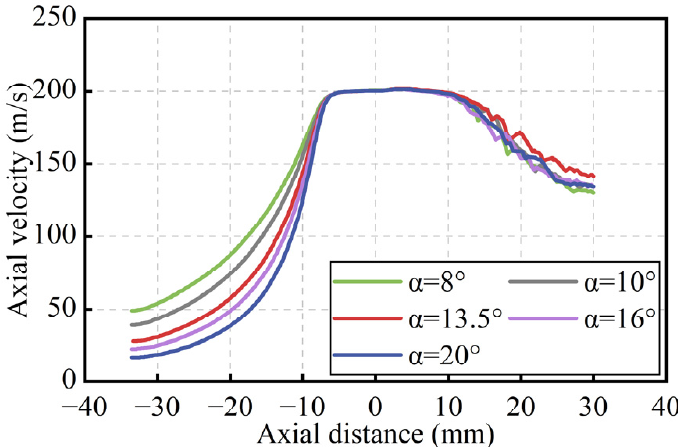
Figure 16. Effect of α on the fluid velocity.